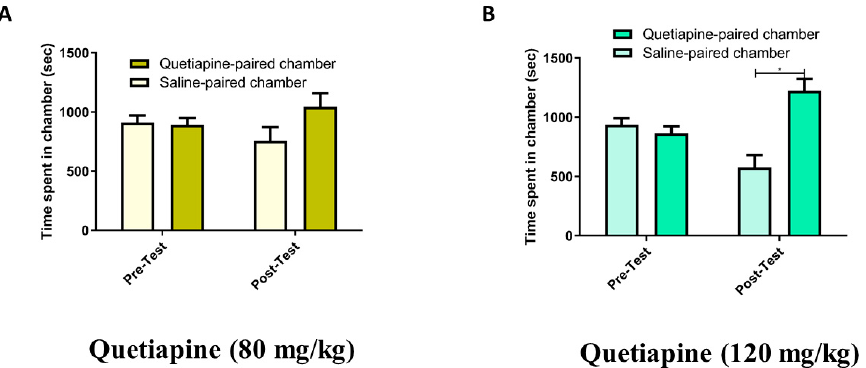
Figure 2. ( A ) Time spent in the quetiapine-paired chamber compared with the saline-paired cham- ber during pretest and post-test in the Quet-80 group (treated with quetiapine; 80 mg/kg). ( B ) Time spent in the quetiapine-paired chamber compared with the saline-paired chamber during pretest and post-test in the Quet-120 group (treated with quetiapine; 120 mg/kg). Values are shown as means ± standard errors of the means. * p < 0.05 compared with the saline-paired cham- ber.